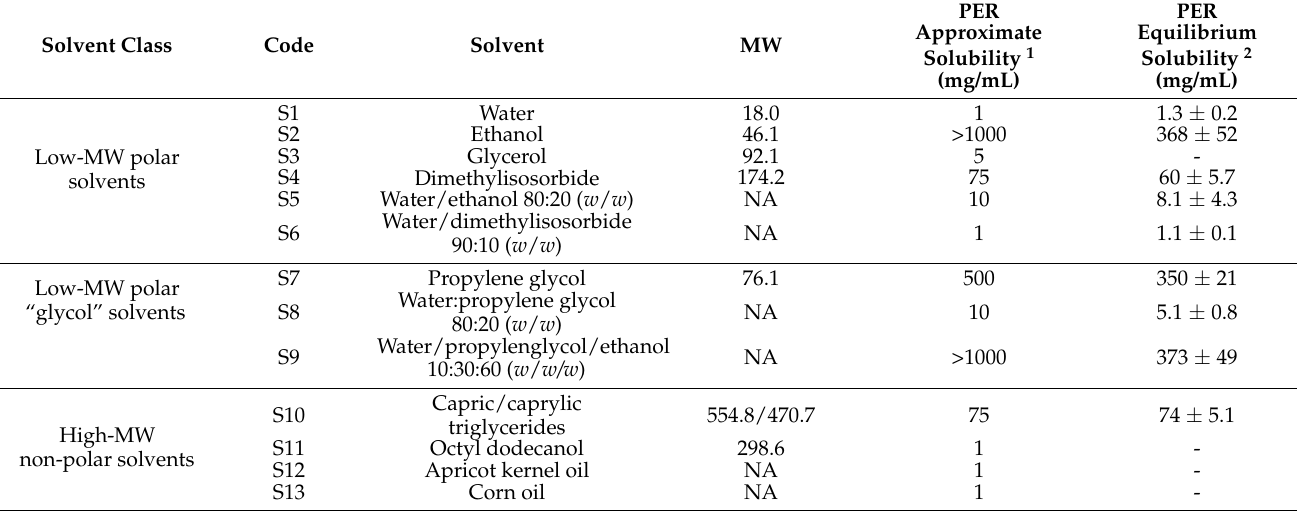
Table 2. Solvents used in the study and the solubility of PER in different